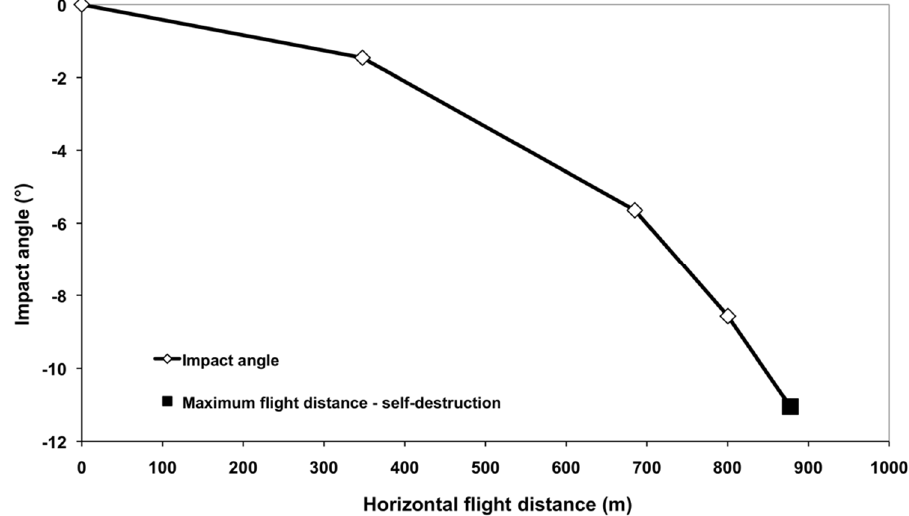
Figure 28. Impact angle as a function of horizontal flight distance (range).